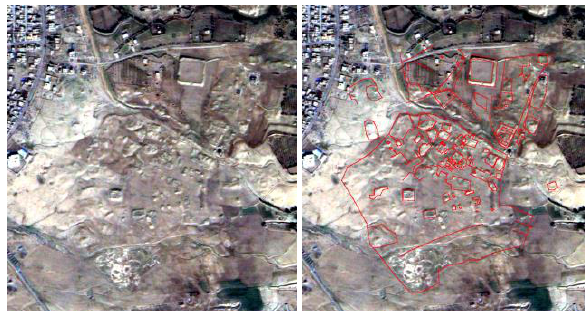
FORMOSAT-2 images (acquired on 2 11. 2014) with an overlaid objects of interest on the left picture